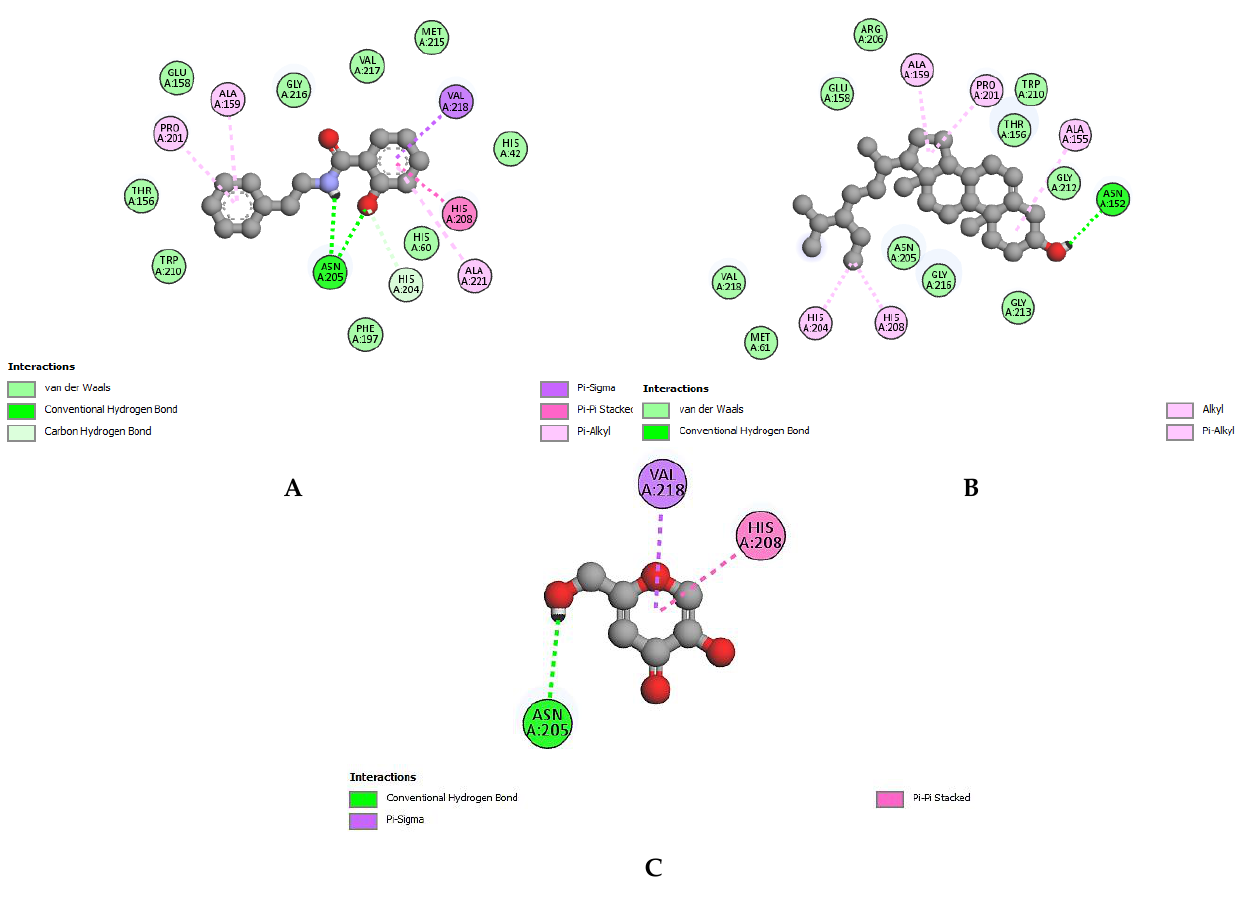
Figure 3. Interaction between tyrosinase and ligand. ( A ) 2-hydroxy-n-(2-phenylethyl) benzamide, ( B ) γ -sitosterol, and ( C ) Kojic acid.